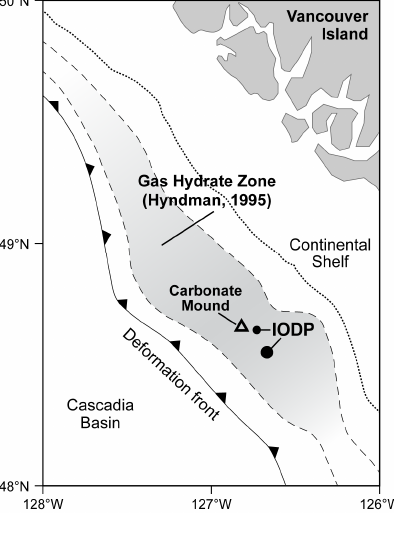
Figure 2. Canadian Western coast GH bottom simulating reflection (BSR) occurrence zone and the location of the International Oceanic Drilling Project (IODP) Expedition 311